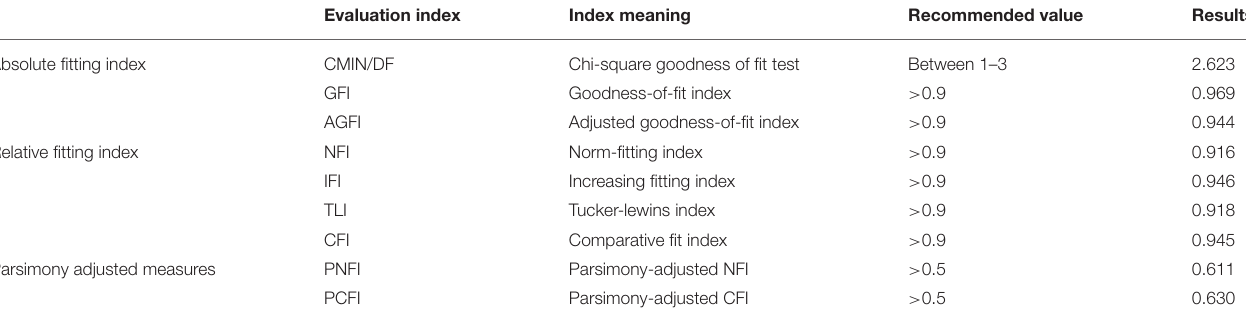
TABLE 7 | Goodness-of-fit test.